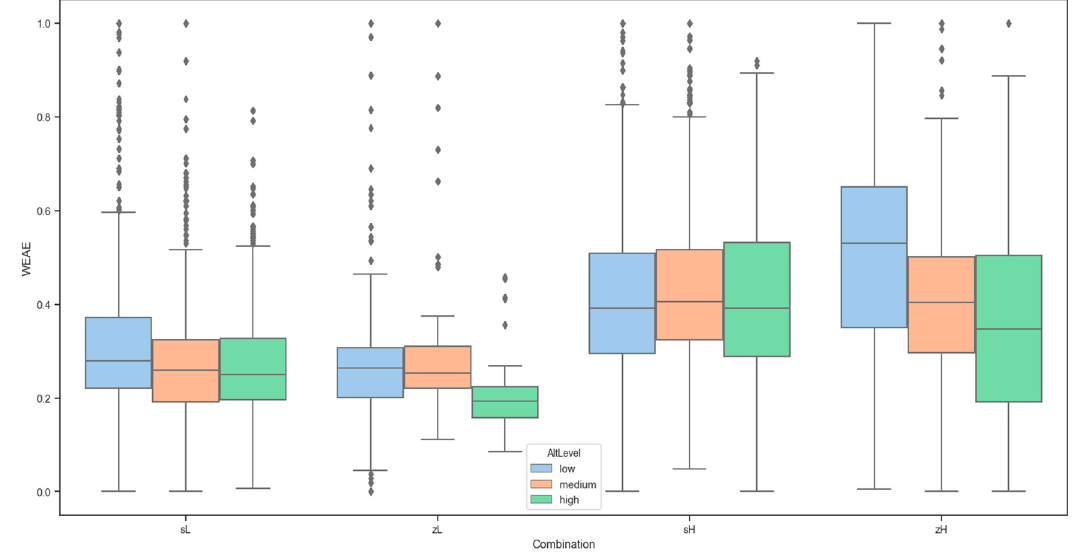
Figure 9. Gas measurement relative values according to each combination of flight path: spiral + Low wind (sL), spiral and High wind (sH), zigzag and Low wind (zL) and zigzag and High wind (zH).